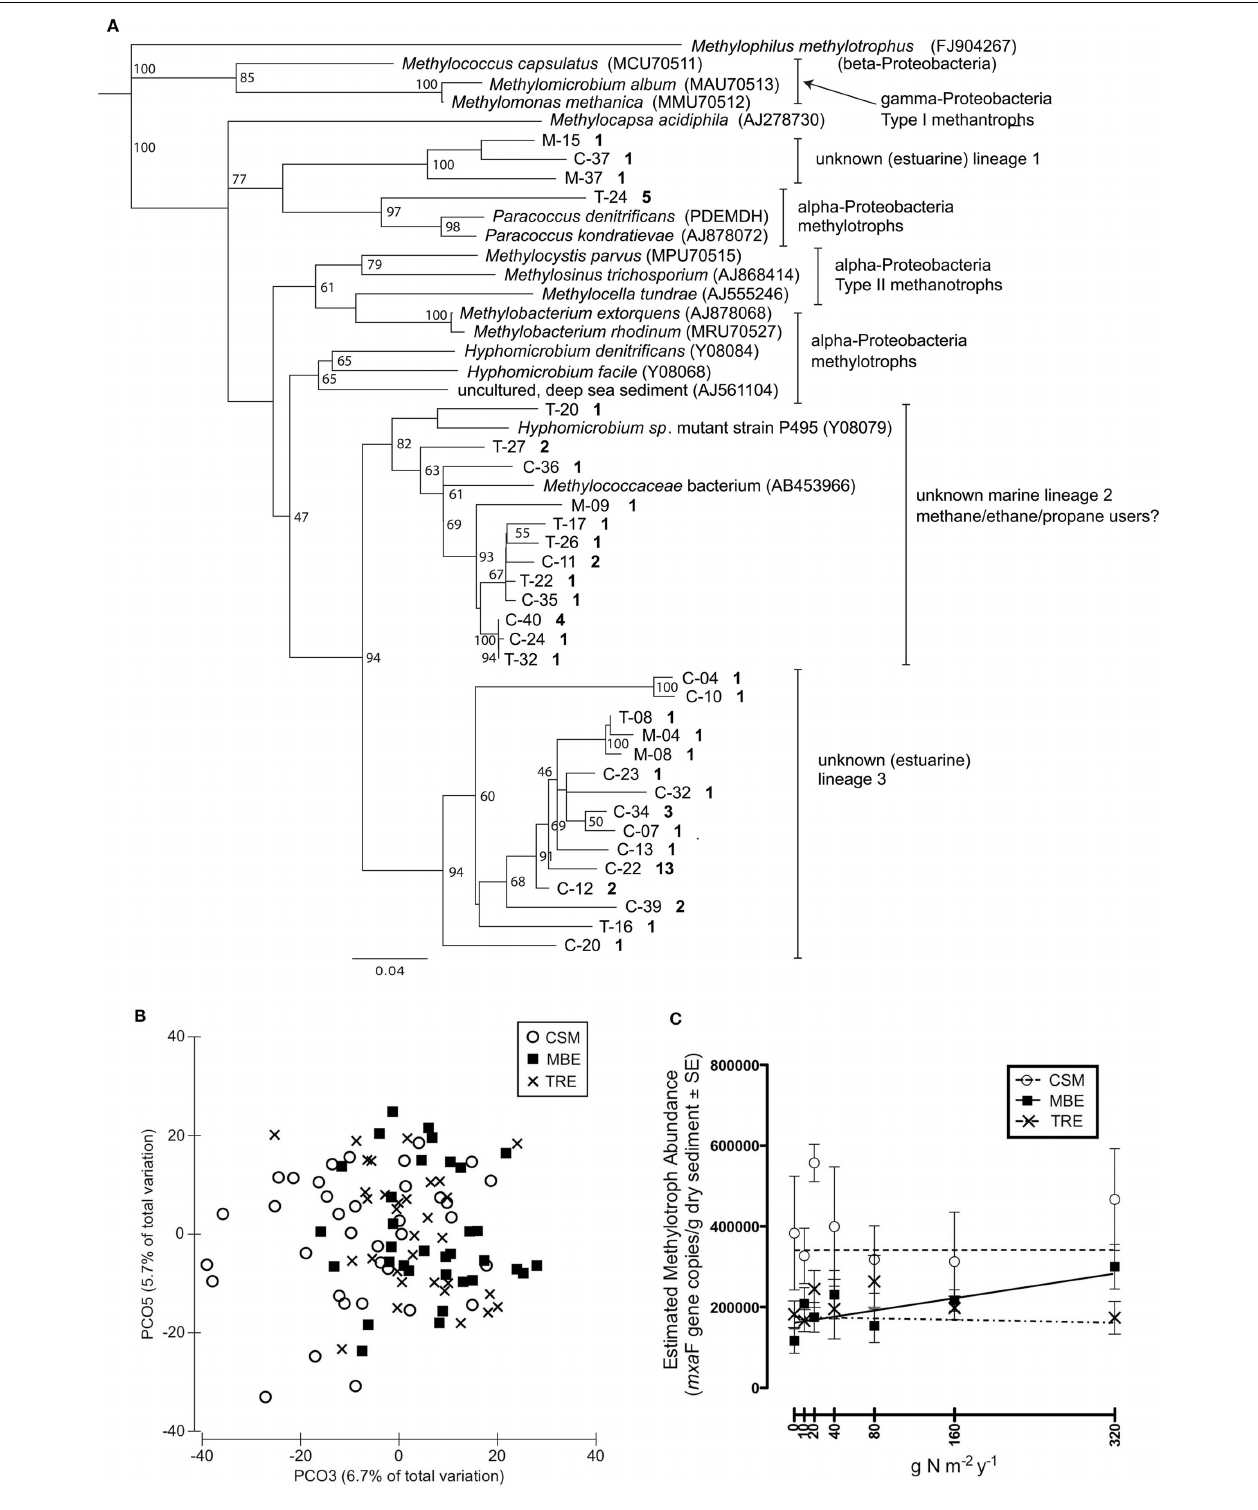
Estuary,T = Tijuana River Estuary.The bold number is the number of sequences that fall within the OTU; only bootstrap values ≥ 50 are shown; (B) Two PCO axes of theT-RFLP profiles that illustrate differences by marsh location (N = 103); (C) Mean mxa F gene copy number per gram dry sediment (N =